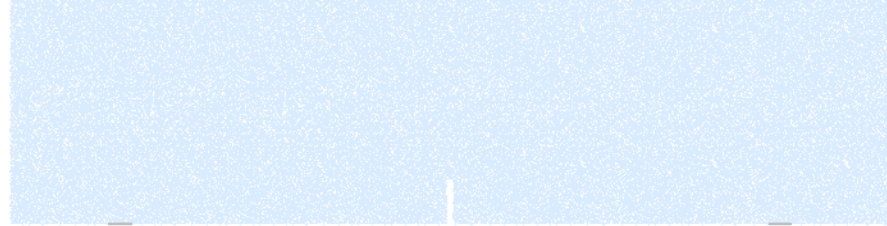
Figure 4. Mortar specimen shape and boundary condition.